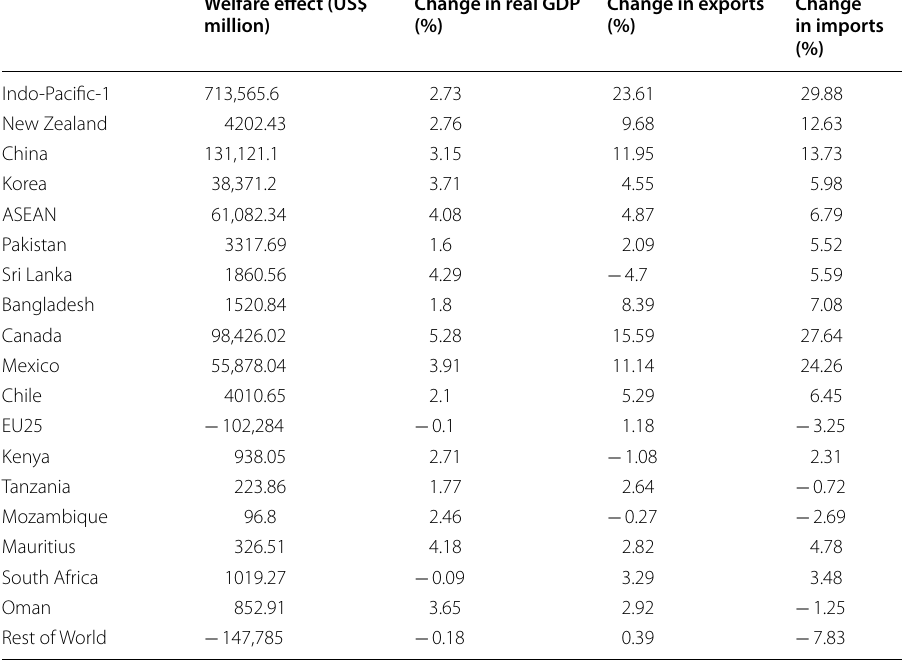
Table 11 Macroeconomic impact of tariff elimination and 25% increase in trade facilitation under Indo-Pacific 4. Source: Authors’ simulation from GTAP version